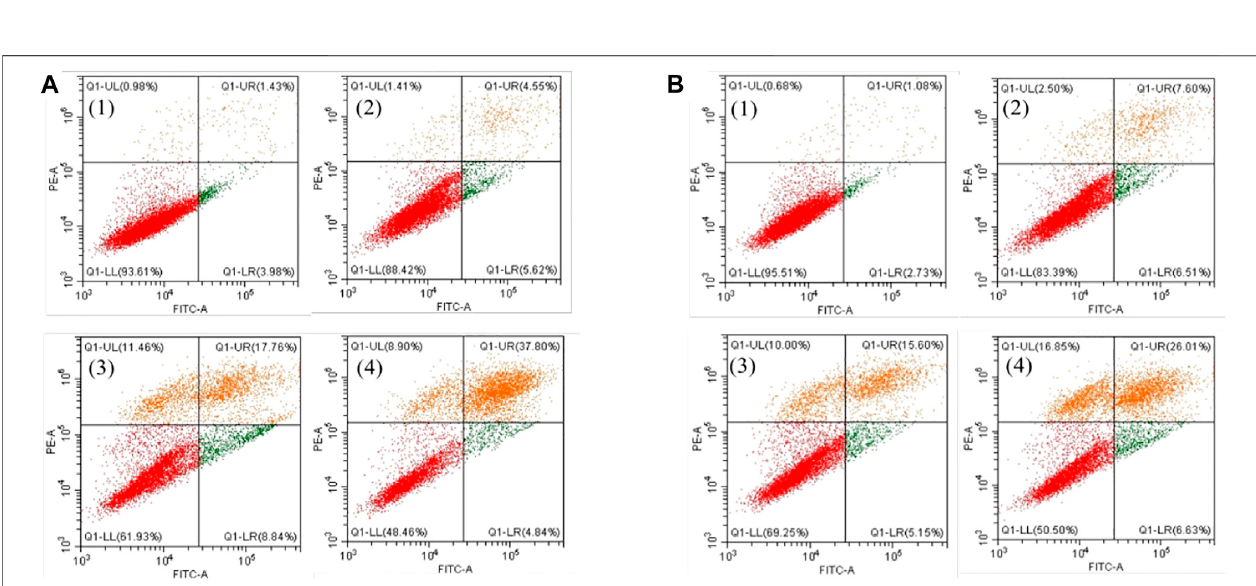
FIGURE 9 | Effects of the Fe complex (A) and the HSA Fe complex adduct (B) on the apoptosis of HeLa cells. (1: 0 μ M; 2: 0.5 μ M; 3: 0.8 μ M; and 4: 1.0 μ M).